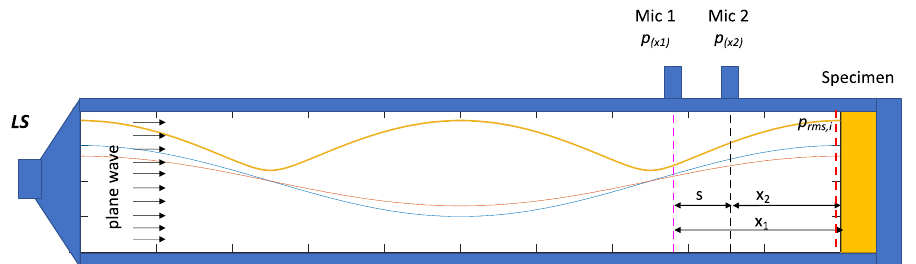
Figure 2. Scheme of determination of the sound absorption by means of an impedance tube. The curves indicates the amplitude of incident (blue curve), reflected (red curve) normal incidence plane wave and the standing wave ratio (yellow curve). Where p ( x 1–2) and Mic 1–2 denote the microphone positions, where the sound pressure is measured related to the x -coordinate, p rms , I is effective values of the incident sound pressure at the surface of the specimen (derived from measurement), s is distance between microphone positions, x 1 , x 2 are distances from of the microphones 1 and 2 to the specimen surface, respectively, and LS is loudspeaker.